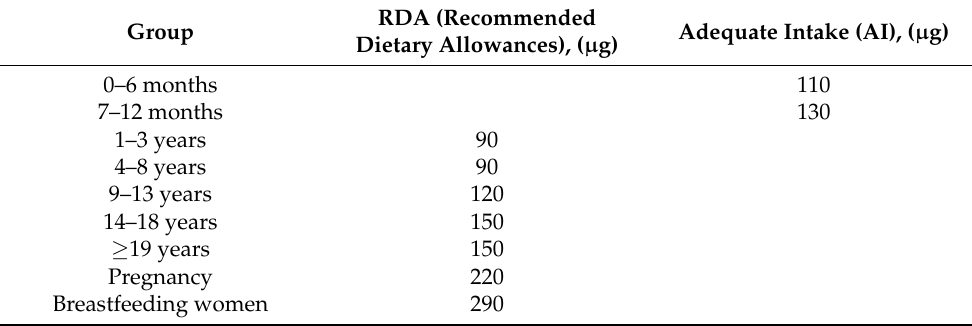
Table 1. Recommended dietary allowances and adequate Intake for iodine [45,46]. RDA (Recommended Adequate Intake (AI), ( µ Group Dietary Allowances), ( µ g)